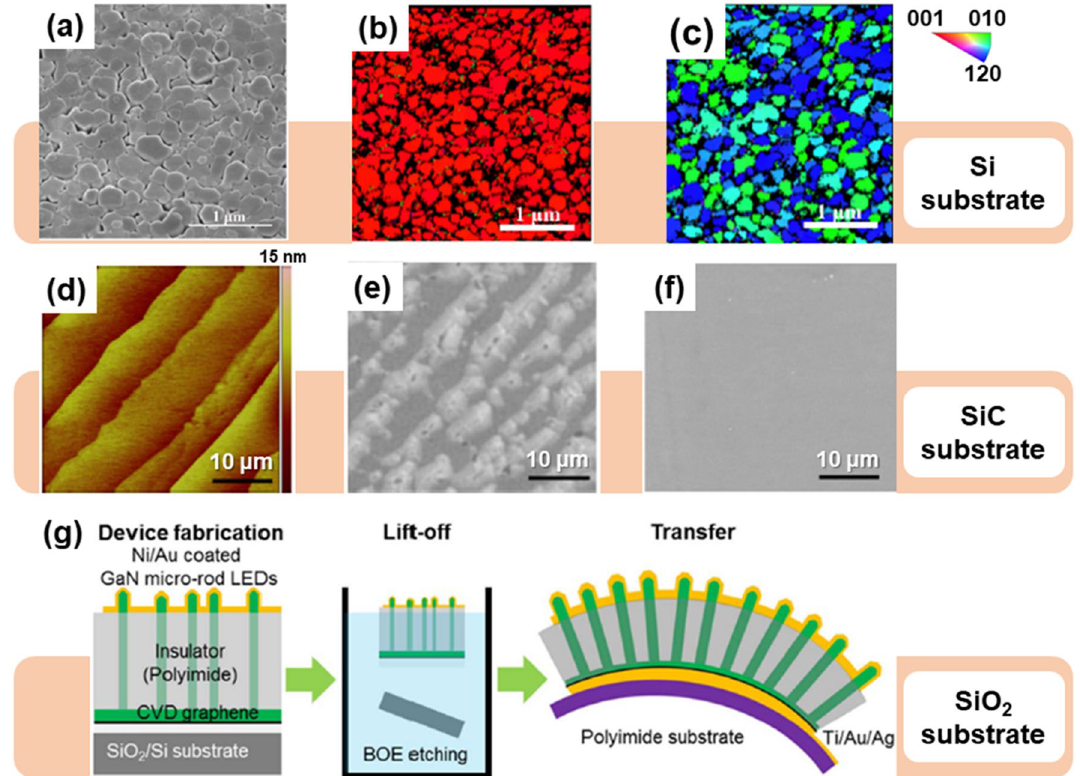
Fig. 4 Epitaxy of graphene on non‑nitride substrate. a The tilted‑view SEM image of AlGaN nanorods on graphene/Si (111). b the normal‑direction EBSD inverse pole figure (IPF) image of on graphene/Si (111). c the transverse‑direction EBSD IPF image of AlGaN nanorods on graphene/Si (111). Figure reproduced from ref. [174], MDPI. d AFM image of the surface of a graphitized SiC substrate. e Plan‑view SEM images of GaN films grown on graphene by one‑step growth at 1100 ºC, and f modified two‑step growth. Figure reproduced from ref. [8], Springer Nature Ltd. g A schematic illustration of the fabrication process for vertical structure micro‑rod LEDs. Figure reproduced from ref. [175], AIP